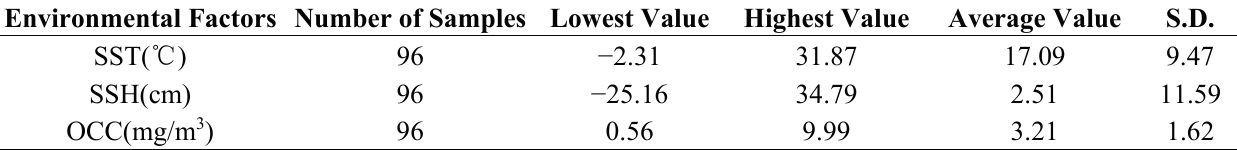
Table 1. Descriptive statistic of oceanic environmental